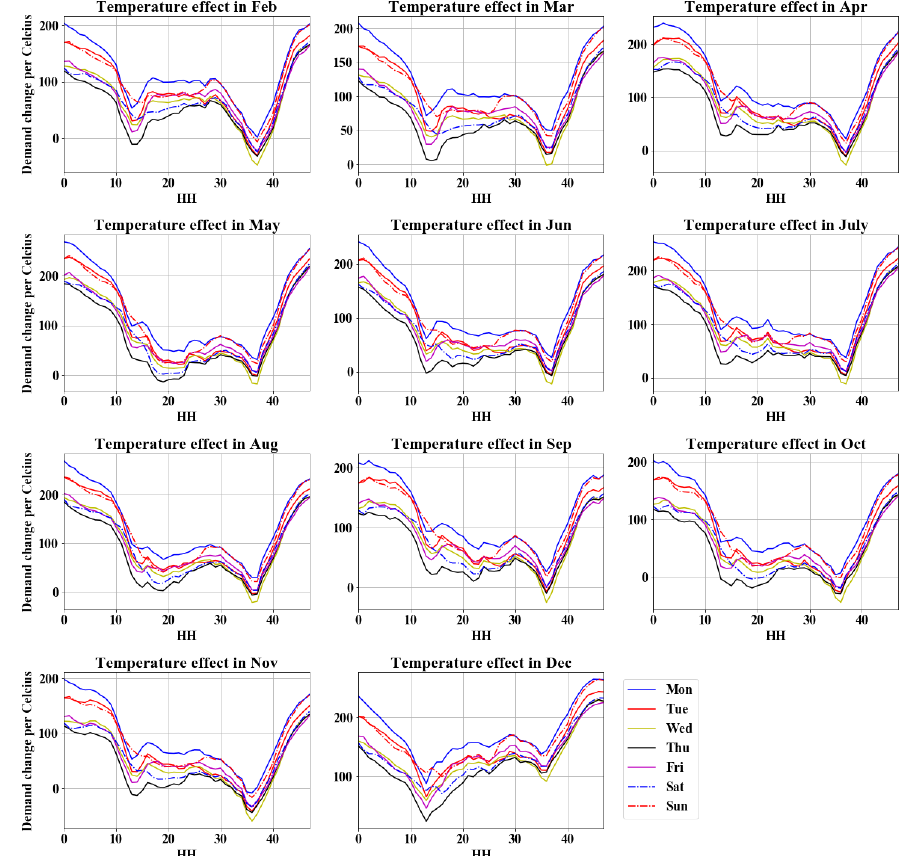
Figure 2. Demand variation per degree change in